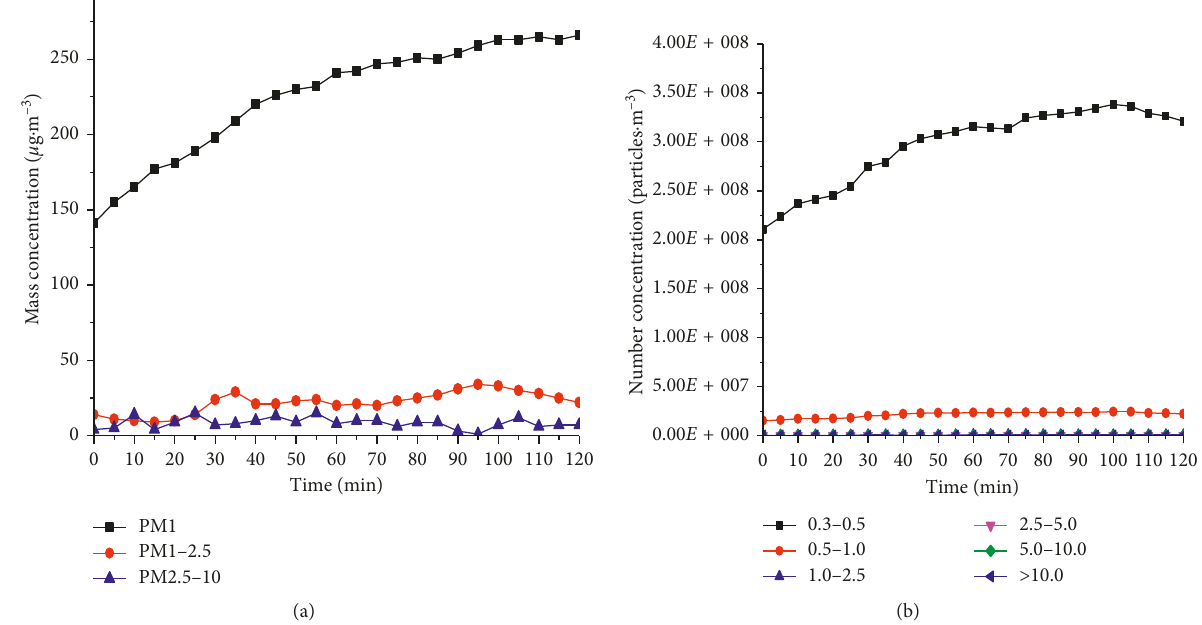
Figure 5: The indoor particle concentration in outdoor PM10 � 500–600 μ g · m − 3 : (a) mass concentration; (b) number concentration.